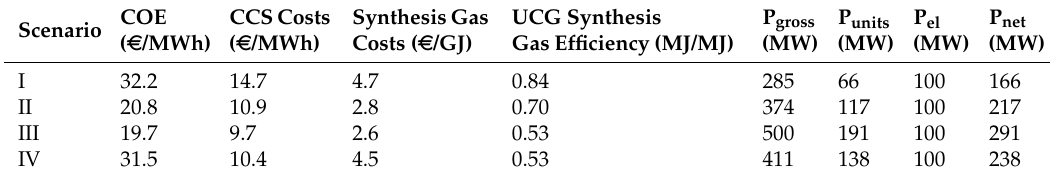
P gross = total gross power generation, P units = power required to operate all integrated process units, P el = electric power output, P net = net power generation consisting of P units and P el